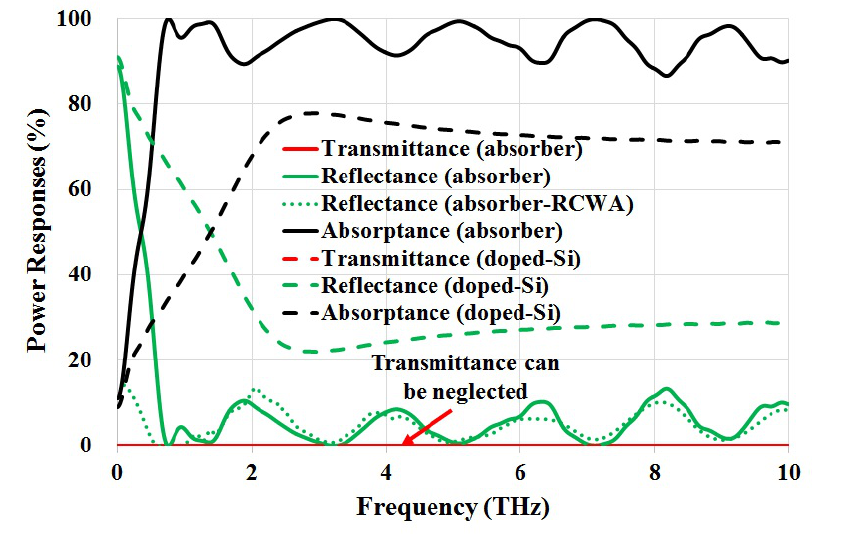
Figure 2. Simulated power responses for the proposed absorber and a bare doped silicon